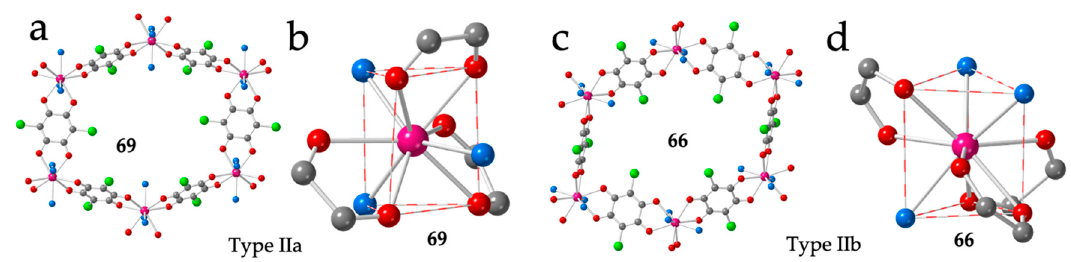
Figure 9. ( a ) View of one hexagonal ring in compound 69 showing the two face ‐ on and four edge ‐ on anilato rings. ( b ) View of the coordination environment of the Dy(III) ion in compound 69 . ( c ) View of one hexagonal ring in compound 66 showing the four face ‐ on and two edge ‐ on anilato rings. ( d ) View of the coordination environment of the Er(III) ion in compound 66 . Colour code: Ln = pink, C = grey, O anilato = red, Cl = green and O solvent = blue.